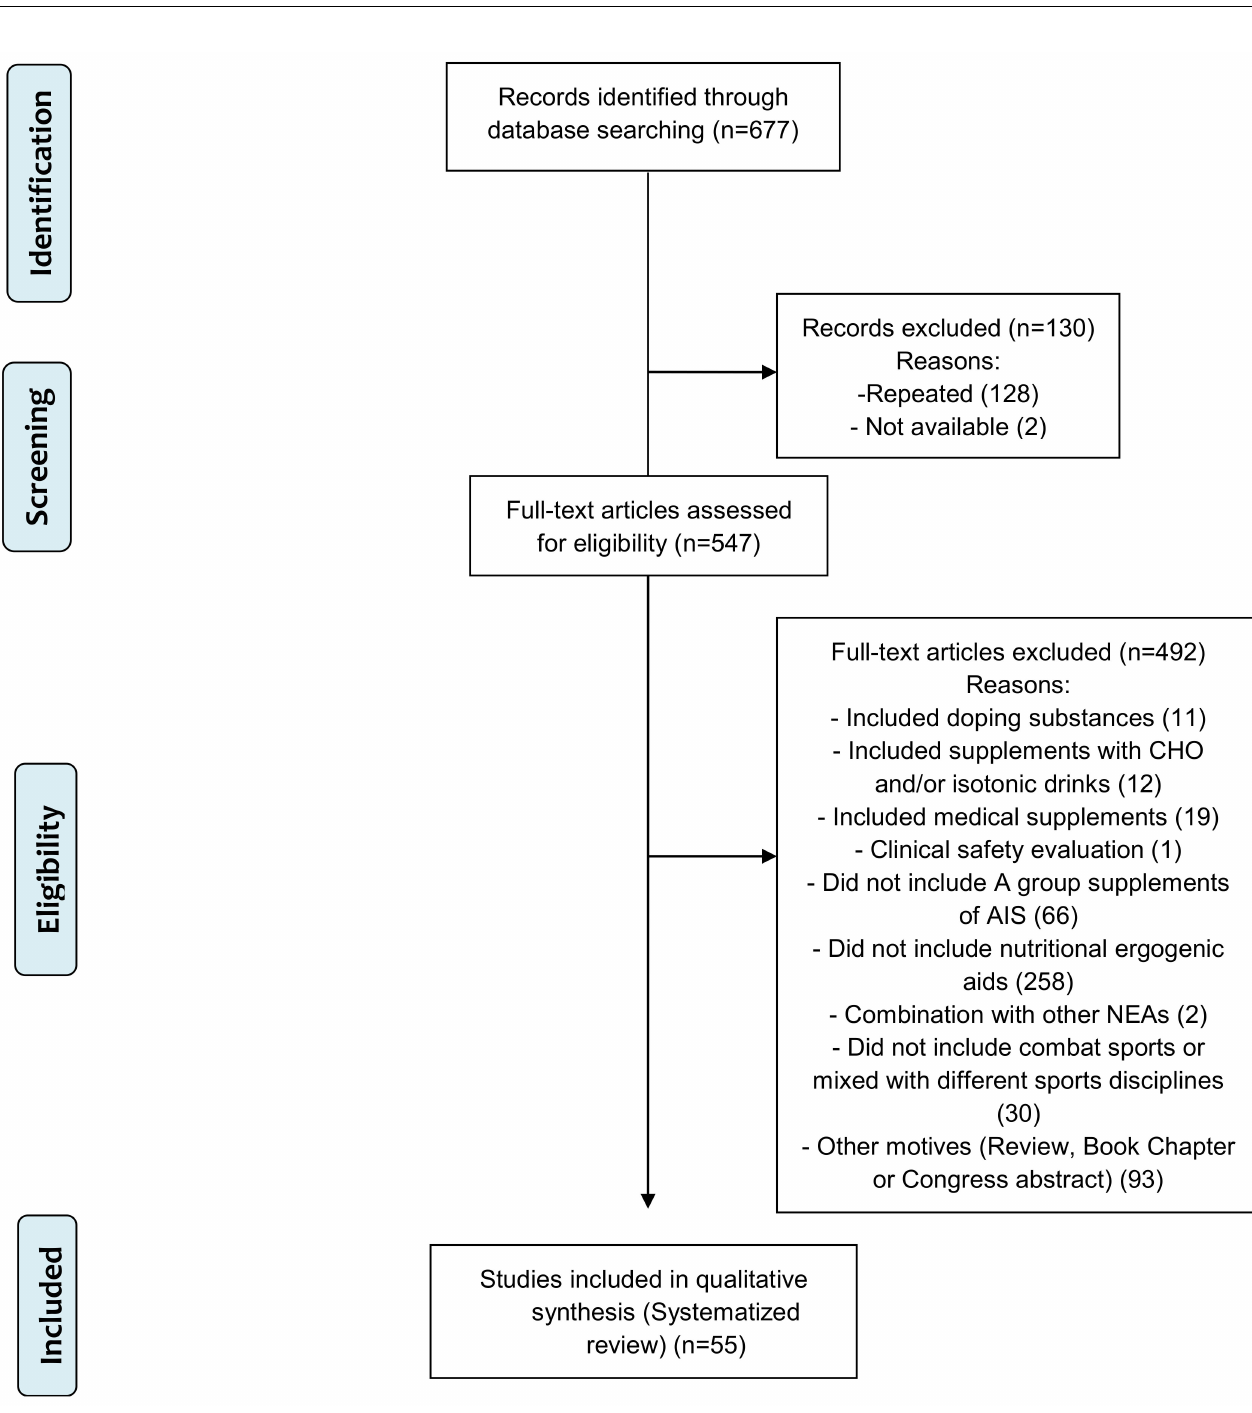
Figure 1. PRISMA flow chart [16] of the study selection